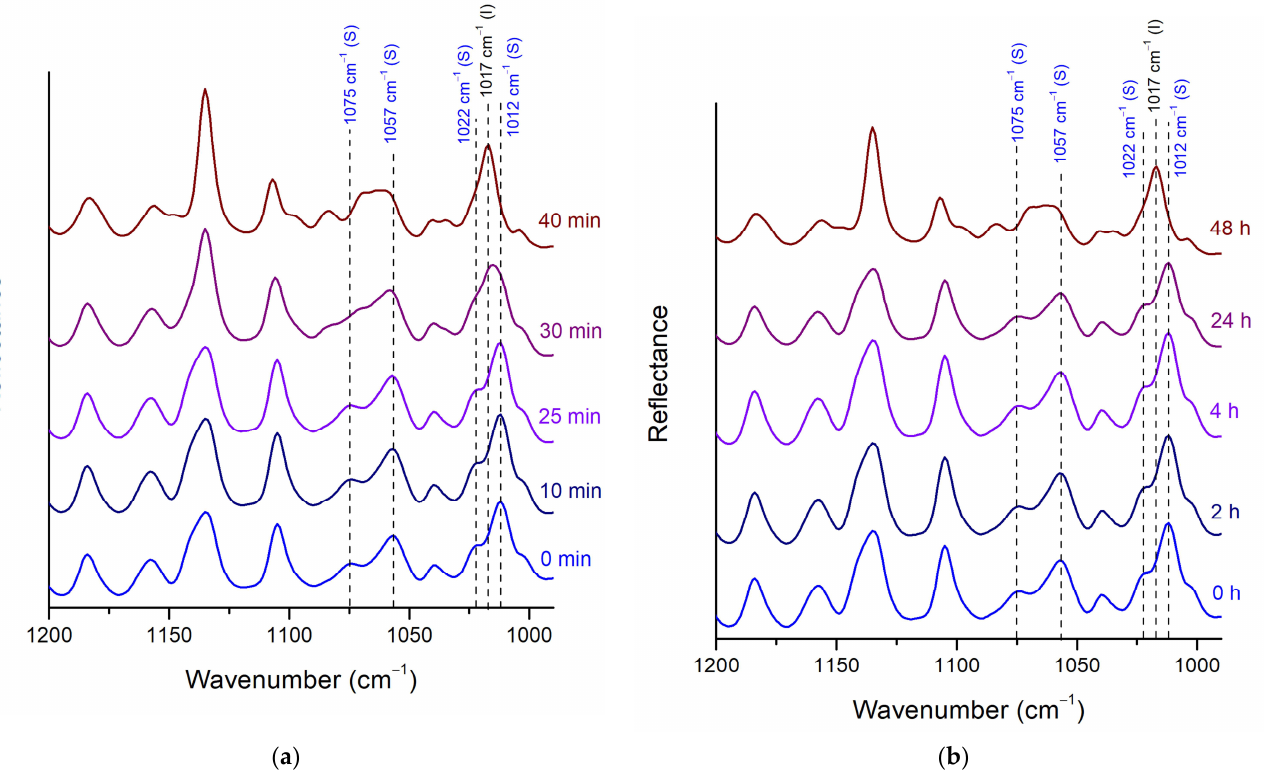
Figure 7. Stability of pure posaconazole Form-S in ambient conditions investigated through ATR spectroscopy ( a ) without using a cover; ( b ) using LDPE cling film as a cover (black peak labels: characteristic peaks for posaconazole Form I; blue peak labels: characteristic peaks for posaconazole Form-S). Spectral area: 1200–990 cm −1 .